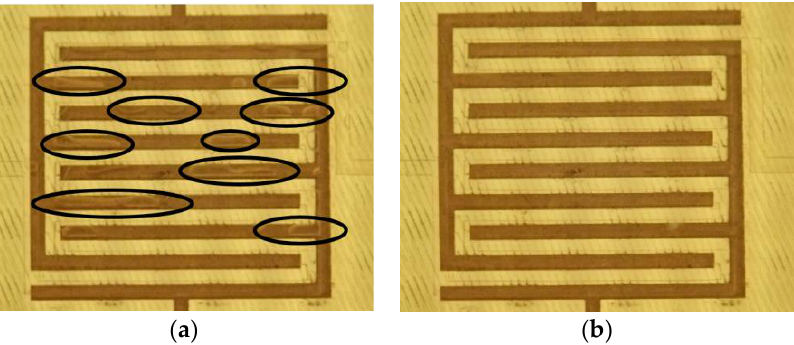
Figure 6. ( a ) Direct sample loading without isopropanol flush showing several bubbles highlighted with black circles; ( b ) sample loading done after isopropanol flush.